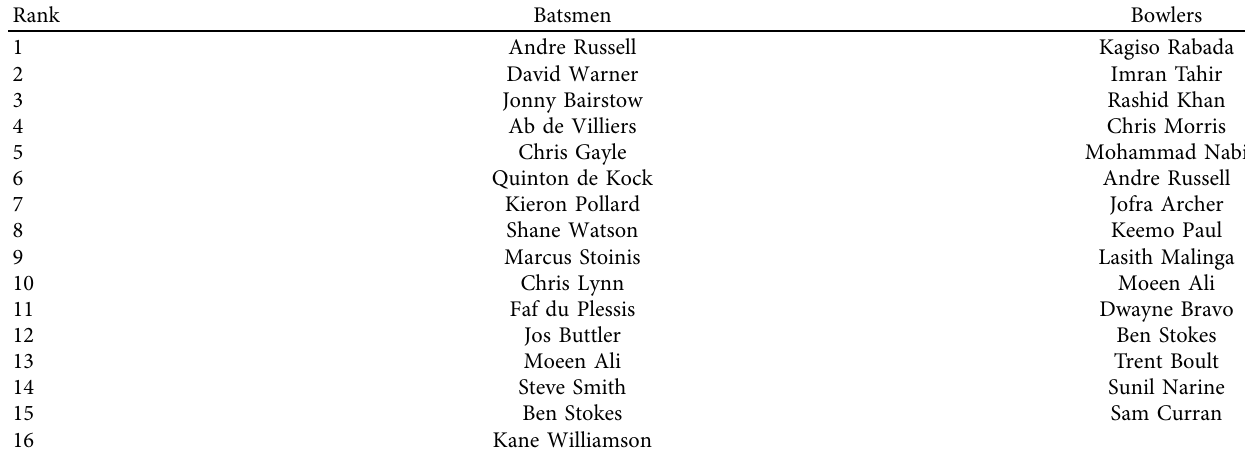
Table 12: Ranks generated by NR-TOPSIS.